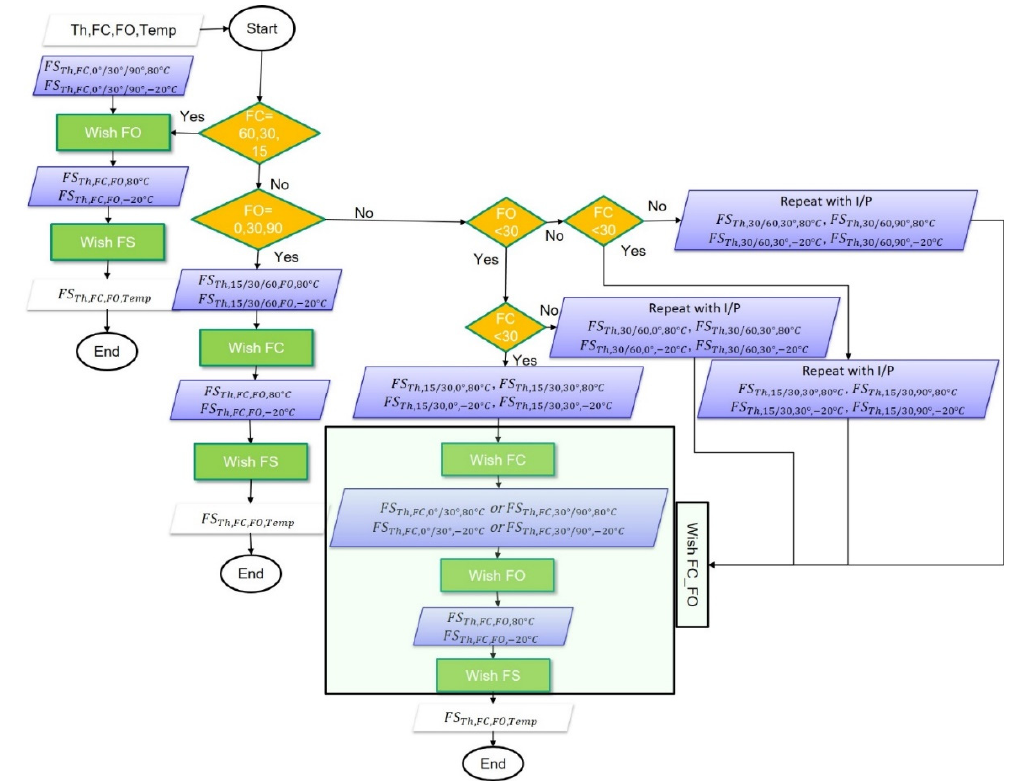
Figure 5. Algorithm used to predict the fracture strain (FS) for each material condition, Th: thickness of the specimen, FO: fiber orientation, FC: fiber content, Temp: temperature, Wish FO, Wish FC, and Wish FS are analytical models to predict values.